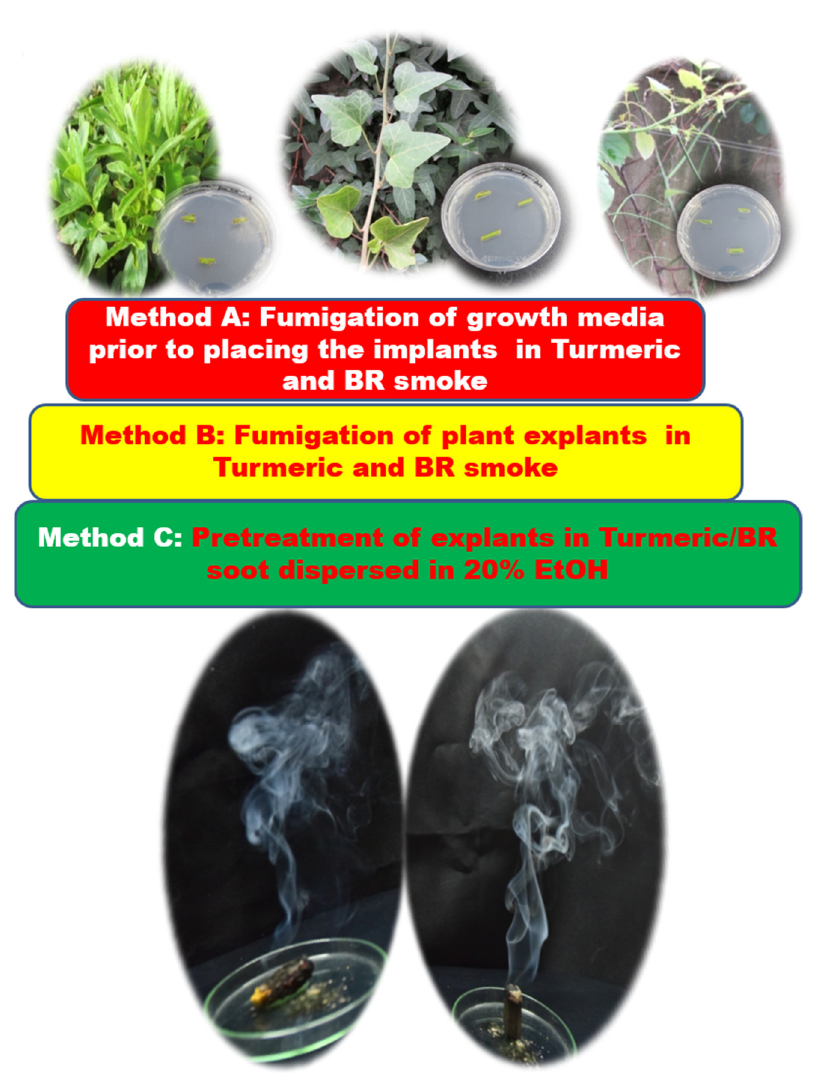
Figure 1. Schematic of the experimental methodology. BR—Benzoin resin